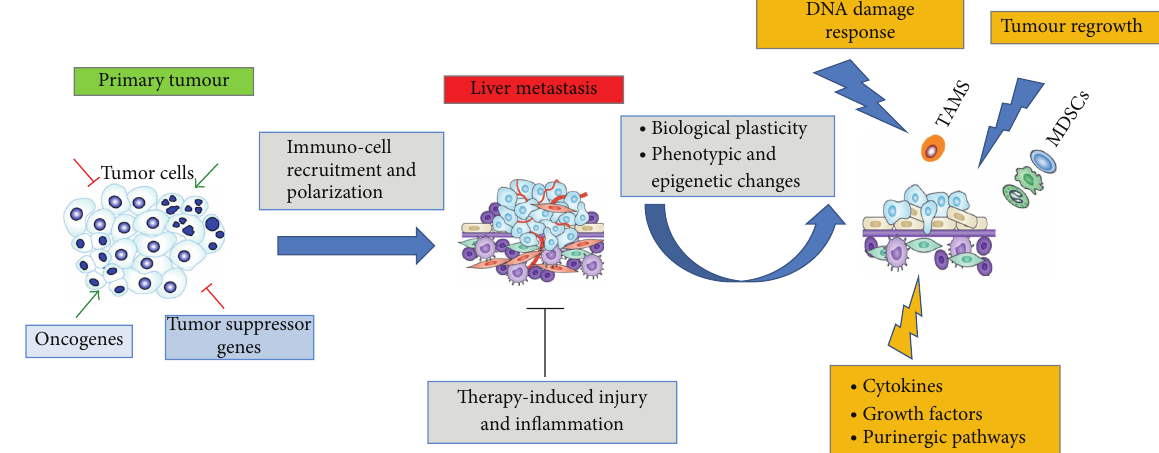
Figure 4: Tumour and immune cells plasticity in therapy-induced tumour tissue damage and development of therapy resistance. Immune cells polarization, soluble mediators, and extracellular matrix components of the tumour microenvironment contribute to progression and livermetastasisbyconstructingtheso-called“premetastaticniche.”Therapy-inducedtumourtissueinjuriesleadtointerconnectedphenotypic alterations of tumour and immune cells. Activity of several drugs (5-FU; gemcitabine and other cytotoxic agents) on (the) malignant cells can be associated with the concomitant TAMs and MDSCs activation or expansion due to enhanced polarization and phenotypic plasticity in metastatic tissues. Consistent with this hypothetical model, extensive tumour tissue injuries and necrosis activate the “inflammasome” and enhance the release of cytokines (IL-1 𝛽 ) and growth factors (TGF- 𝛽 ) and likely activate immune-suppressive pathways mediated by adenosine production (purinergic pathways). In addition, tumour tissue damage, following cytoreductive therapy, results in epigenetic alterations, DNA damage response, increased expression of drug transporters, and DNA-repair enzymes in malignant cells which contribute to protect against cytotoxic drugs and result in therapy resistance and tumour